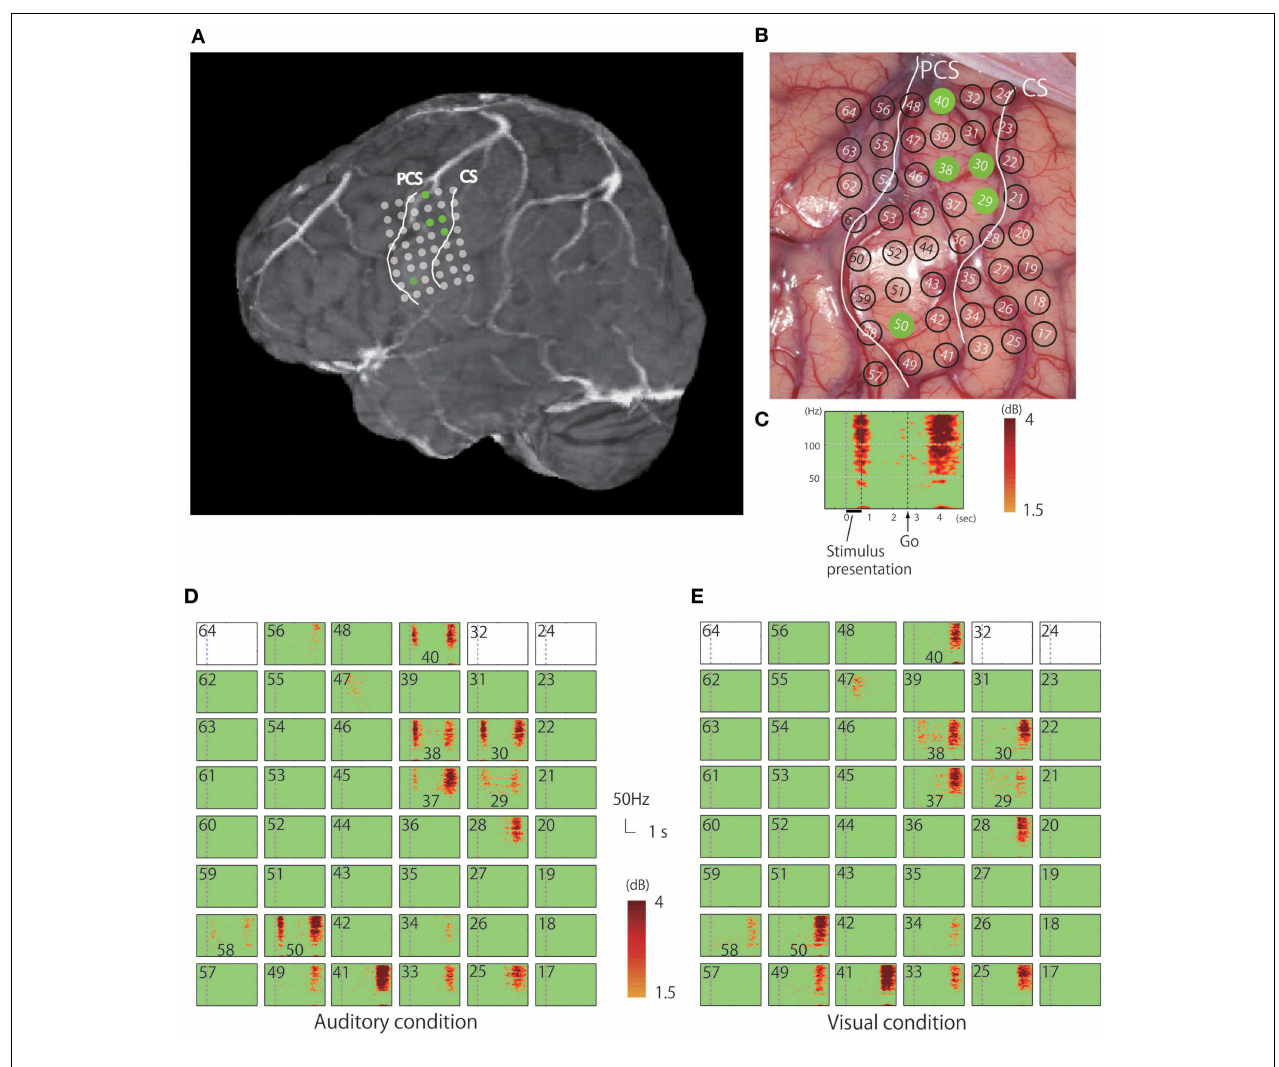
indicate the magnitudes of the response (dB) relative to the baseline period; the purple dotted line indicates the time (0s) when the noun was presented. (D) Time-frequency plots of the recorded signal in response to the verb generation task with auditory noun presentation. (E) Time-frequency plots of the recorded signal in response to the verb generation task with visual noun presentation. Blank rectangles indicate bad